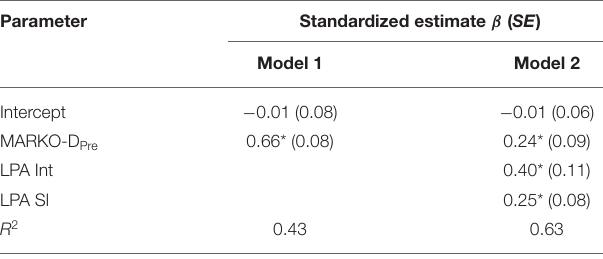
TABLE 6 | Parameters for multiple regression models predicting MARKO-D1 Post ( N = 97 a ). Parameter